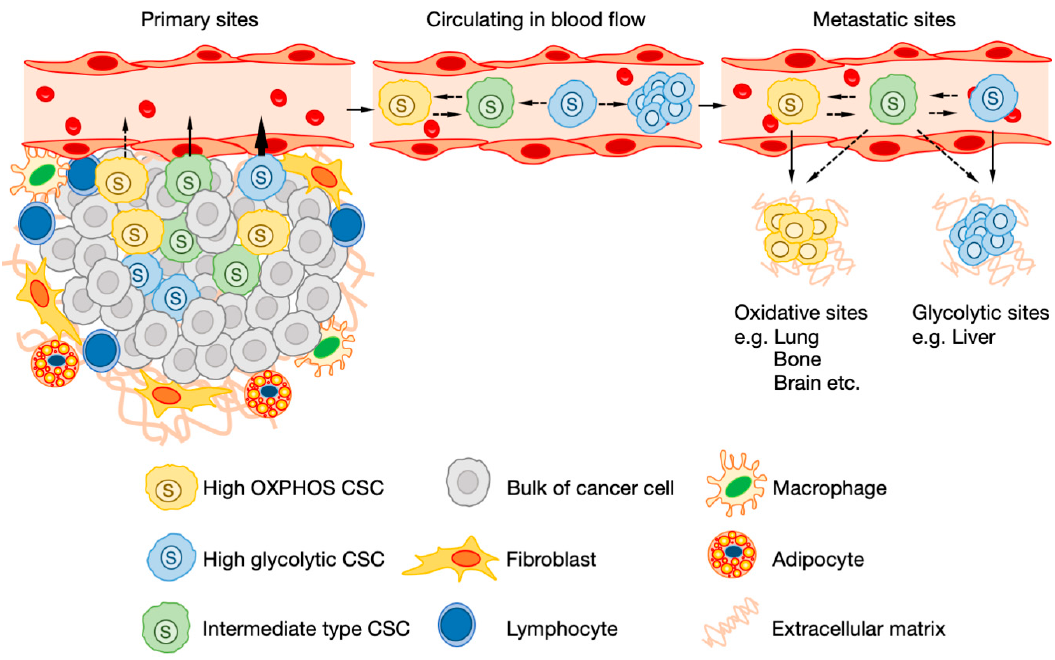
Figure 2. The metabolic heterogeneity and flexibility of cancer stem cells (CSCs). The metabolic phenotypes of each CSC are very heterogeneous even within the same tumor. High glycolytic CSCs have more invasive ability compared to high oxidative phosphorylation (OXPHOS) CSCs. Circulating cancer stem cells are dependent on OXPHOS or have a higher metabolic capacity. Glycolytic CSCs reprogram metabolism to OXPHOS-dependent manner or maintains glycolytic metabolism by forming clusters during circulating. Eventually, CSCs metastasize to organs that are compatible with metabolic phenotypes.